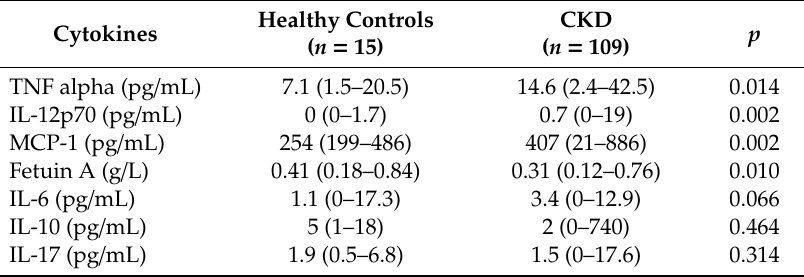
Table 4. Cytokines in CKD patients and healthy